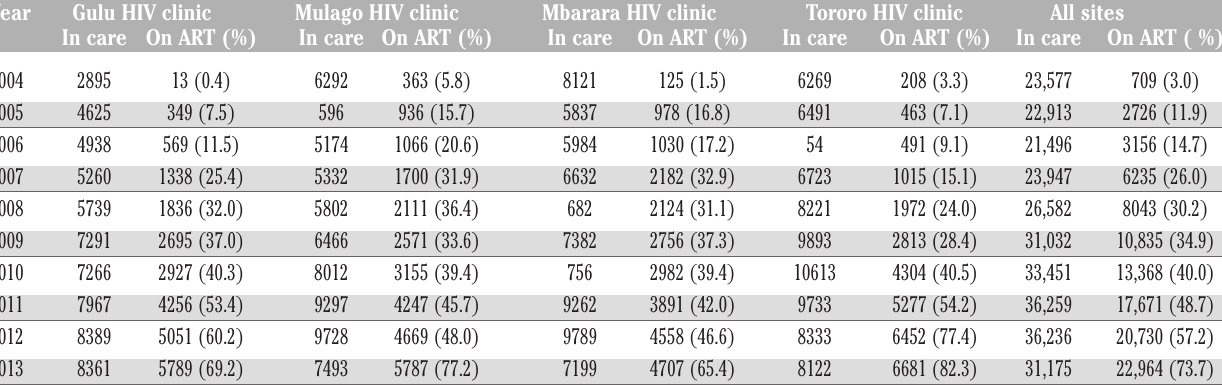
Table 2. Number of study participants accessing highly active antiretroviral therapy (ART) in the period 2004 to 2013, total and clin- ic-specific. Year Gulu HIV clinic Mulago HIV clinic Mbarara HIV